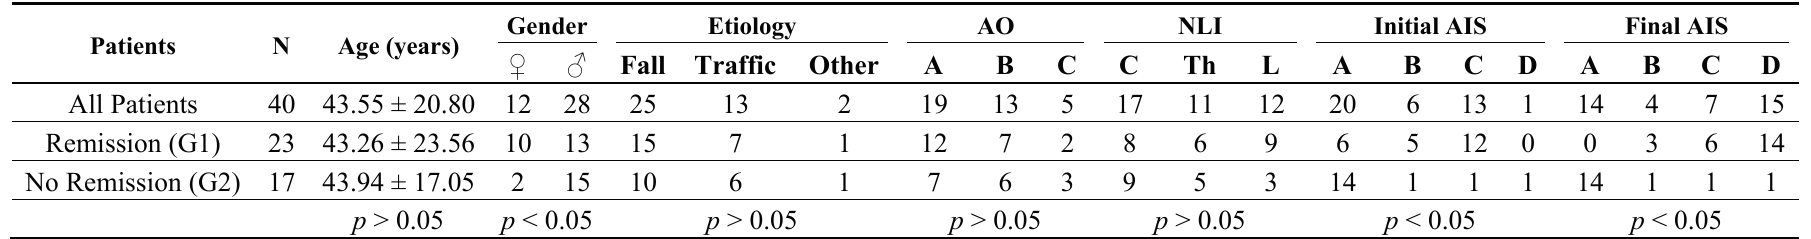
Table 1. Demographic and clinical characteristics of subjects. Abbreviations: NLI = Neurological Level of Injury; AO = AO-Classification; AIS = American Spinal. Injury Association (ASIA) Impairment Scale. Age is expressed as mean years ± standard deviation. Neurological remission was defined as improvement in AIS. Three patients had posttraumatic spinal cord injury (SCI) without vertebral fractures. p -Values were analyzed with χ 2 -test (categorical data) and t -test (age) and show differences in distribution between G1 and